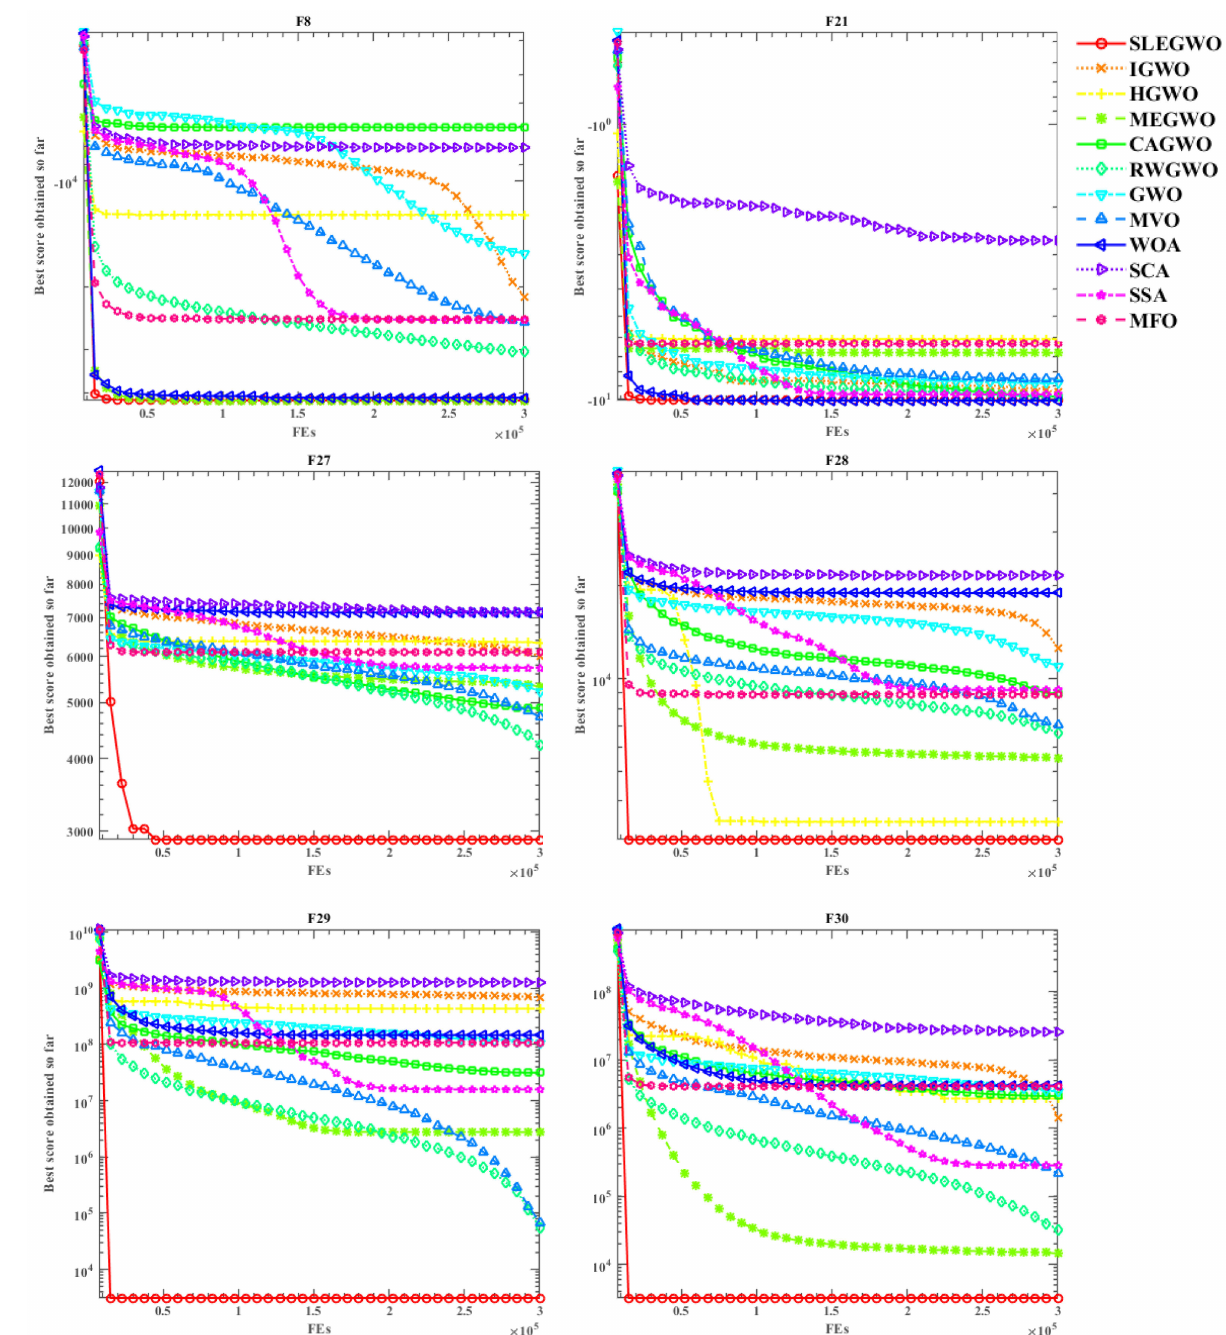
Figure 2. Convergence curves of SLEGWO and other competitors on F8, F21, F27, F28, F29, and